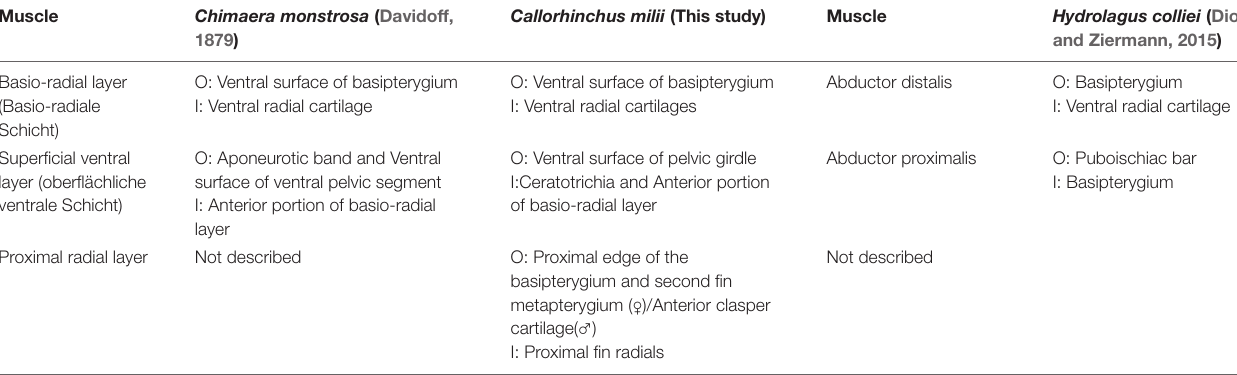
and Ziermann, 2015)